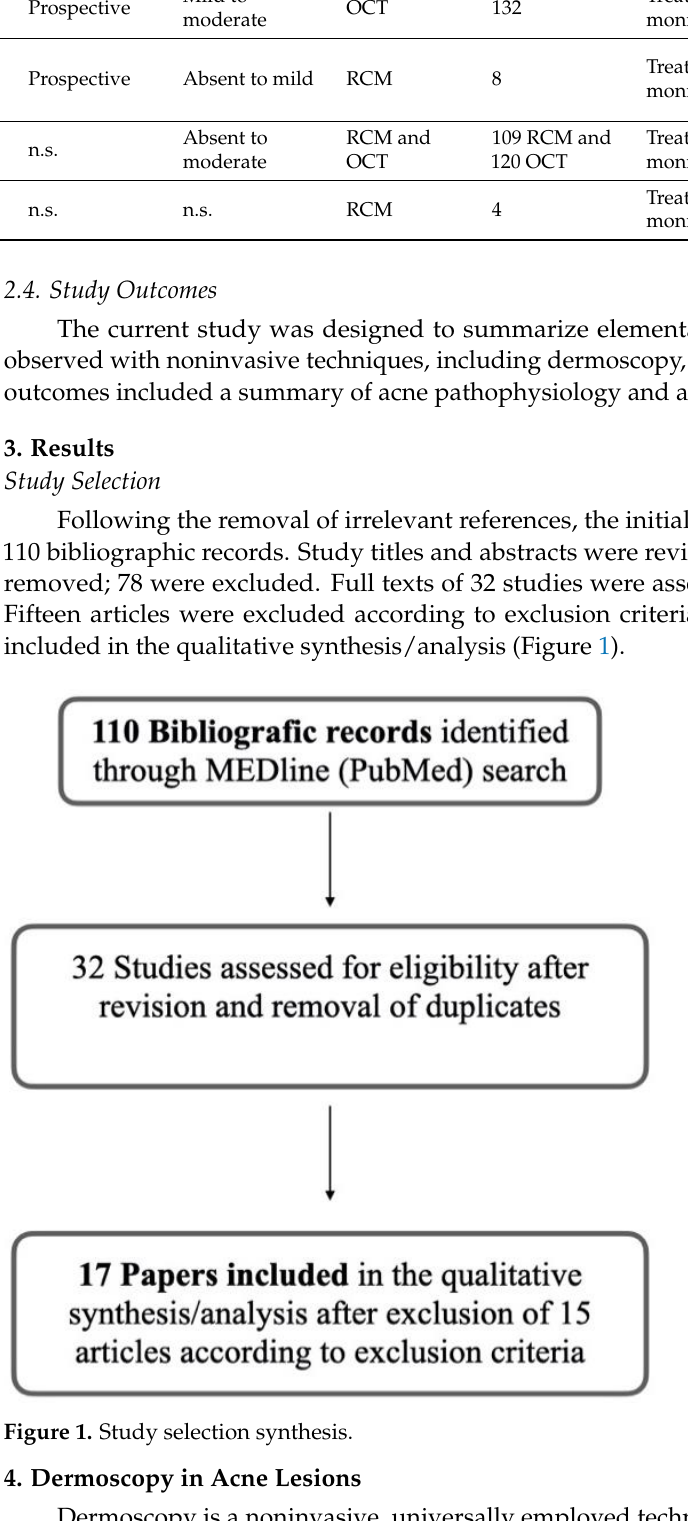
Figure 1. Study selection synthesis.